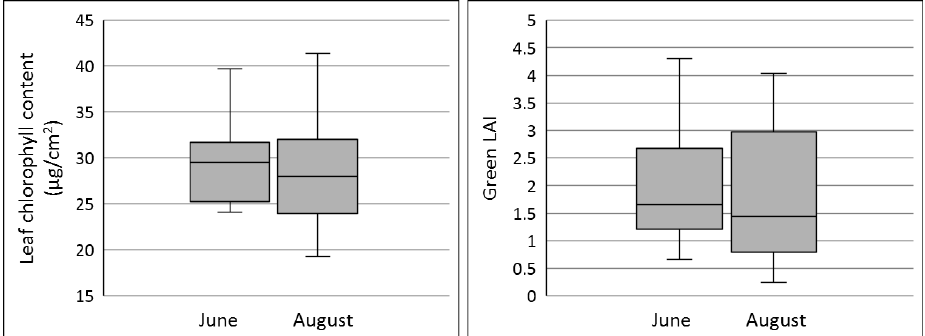
Figure 3 Statistics of the measured leaf chlorophyll and green leaf area index (LAI). Figure 3. Statistics of the measured leaf chlorophyll and green leaf area index